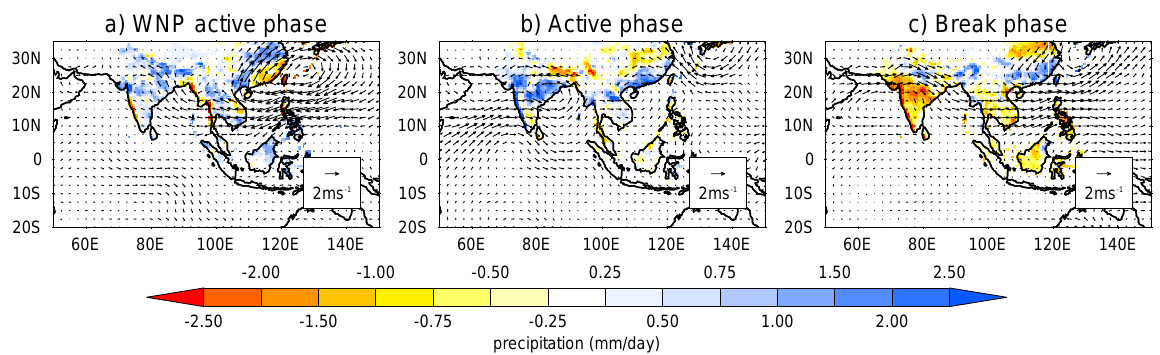
Fig. 12. Composites of APHRODITE precipitation and 850hPa wind anomalies based on the 300 closest data points to the centres of the mixture PDF for the WNP phase (a), the active phase (b) and the break (c) of the ASM. The unit wind vector is 2m s − 1 .